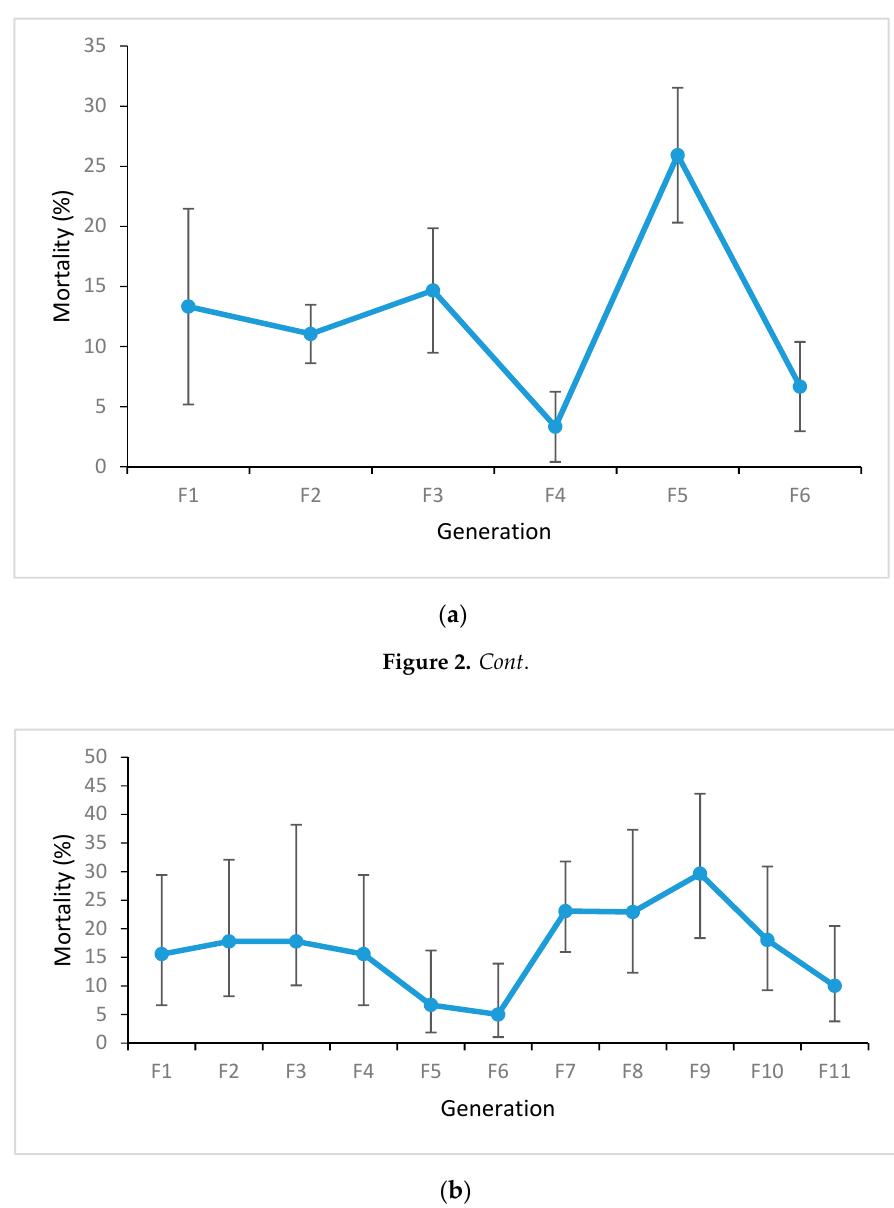
Figure 2. Mortality (%) of female Ae . aegypti adults from ( a ) the field strain from Shah Alam during the F1 to F6 generations in the laboratory, and ( b ) the w AlbB strain from B3F1 to B3F11 generations. Mortality was tested with WHO bioassay impregnated papers (permethrin 0.25%). Error bars represent 95% binomial confidence intervals.